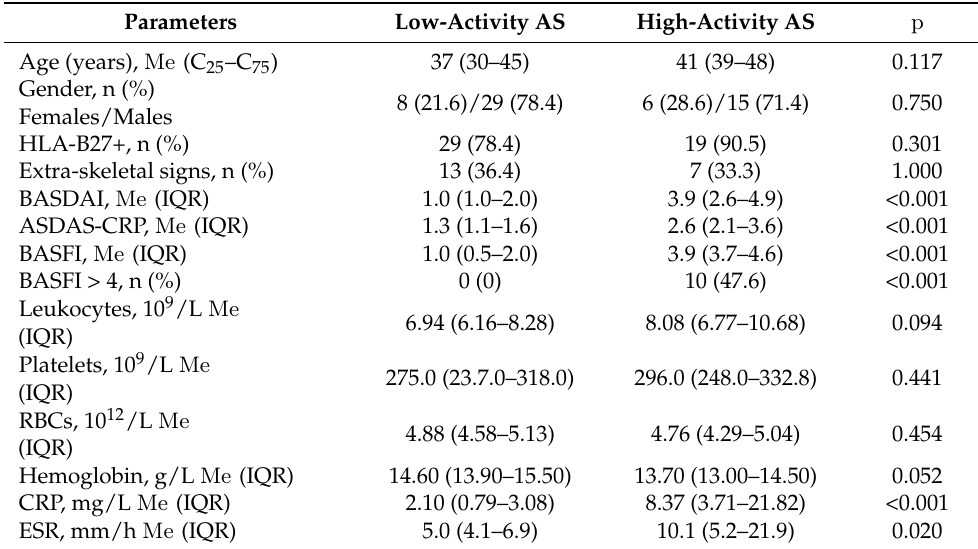
Table 9. Patient clinical characteristics in activity-driven AS.